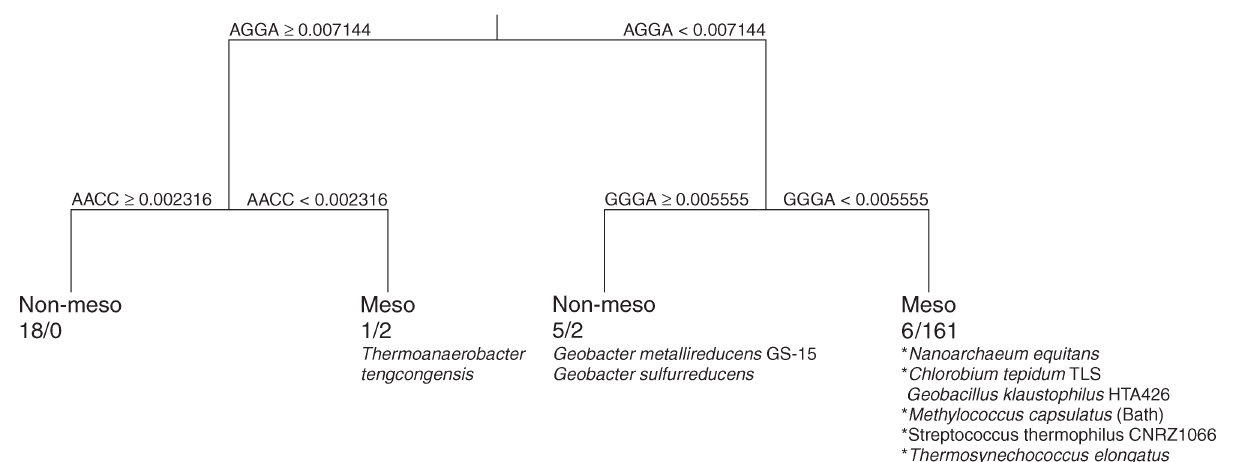
Figure 2. Classification tree of mesophile (meso) versus non-mesophile (non-meso) based on tetramer relative frequencies of 195 genomes. Each splitshows the tetramerselectedby CART for each level of classificationand the relative frequenciesfor each direction. Nodes show the classified temperature range and number of organisms classified in each temperature category according to NCBI (non-meso/meso). Organisms misclassified in this model are listed under the appropriate nodes. Asterisks (*) indicate organisms that may not be misclassified given current un- derstanding of temperature optima (see